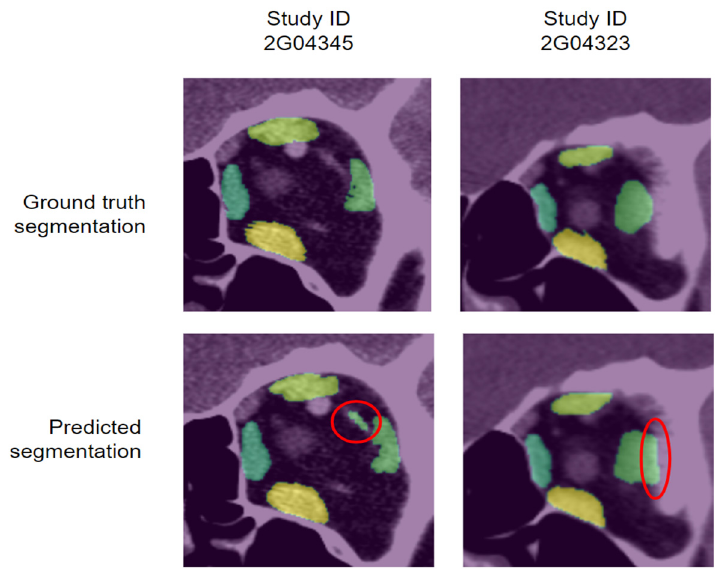
Figure 8. Coronal slice examples from the two test samples whose predicted segmentations were rejected after qualitative evaluation. Red circles outline the areas erroneously predicted by the U-net algorithm